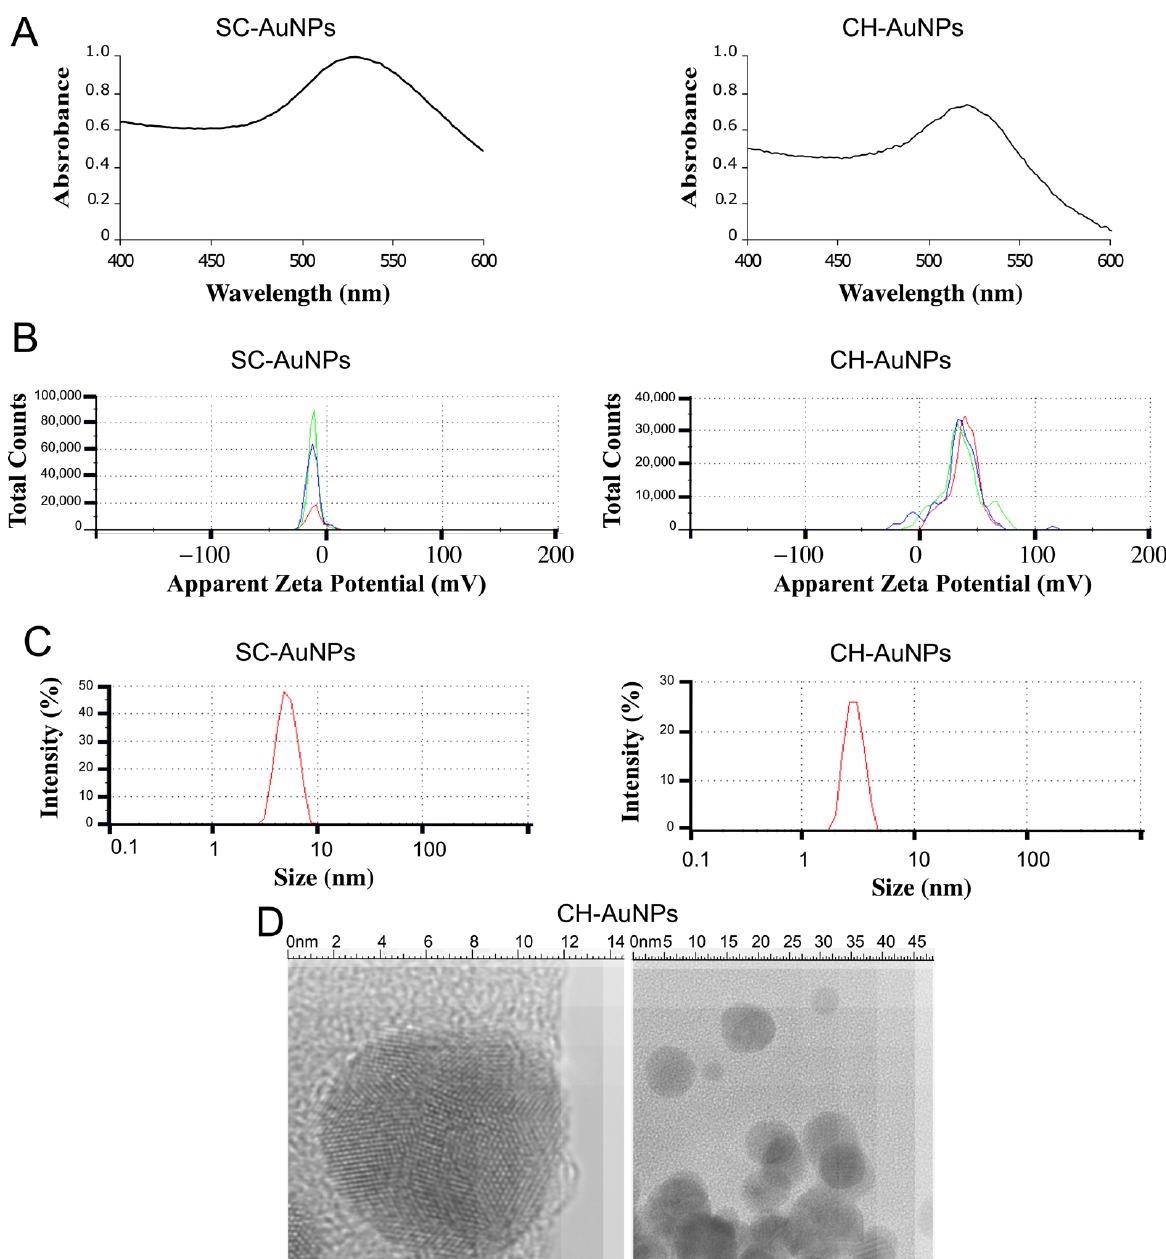
Figure 1. Structure and characterization of SC-AuNPs and CH-AuNPs. ( A ) UV-VIS surface plasmon spectrum of SC-AuNPs and CH-AuNPs. ( B ) Surface charge measured by zeta-potential analysis of SC-AuNPs and CH-AuNPs. ( C ) Size distribution obtained from dynamic light scattering (DLS) analysis of SC-AuNPs and CH-AuNPs. ( D ) Size of CH-AuNPs determined by transmission electron microscopy (TEM).